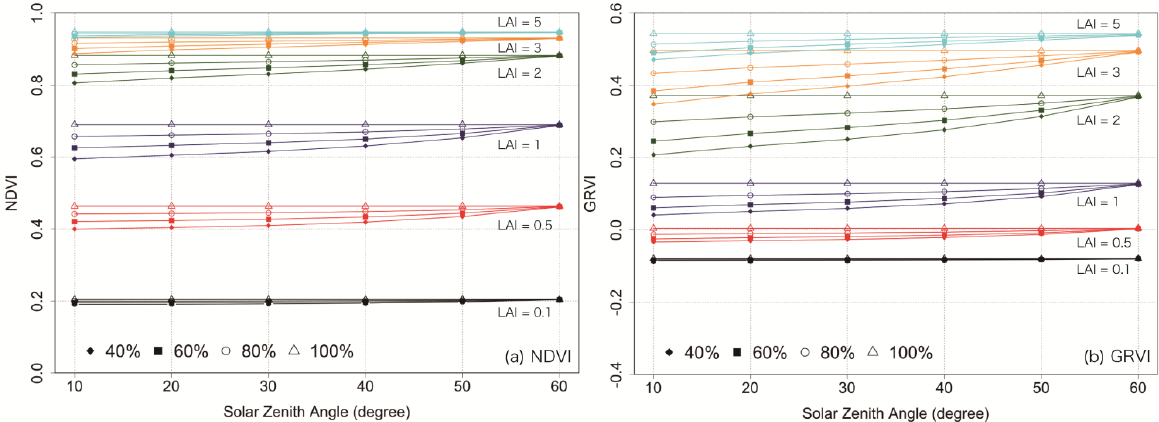
Figure 6. Relation between vegetation indices (( a ) NDVI and ( b ) GRVI) and solar zenith angles simulated by the PROSAIL model for a range of LAI values (0.1, 0.5, 1, 2, 3, 4, 5) and different ratios of diffuse light (40%, 60%, 80%,